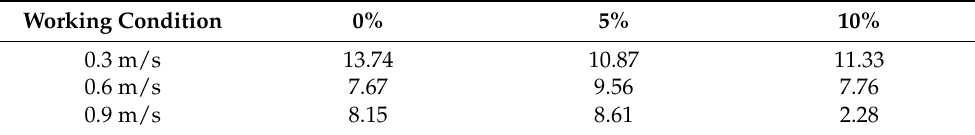
Figure 7. Schematic diagram of fish ascending in the fish passage pipeline (the vital positions for testing have been marked with numbers in the figure). Table 2. Average percentage of T45-R at each vital position lower than GMF velocity (%) .